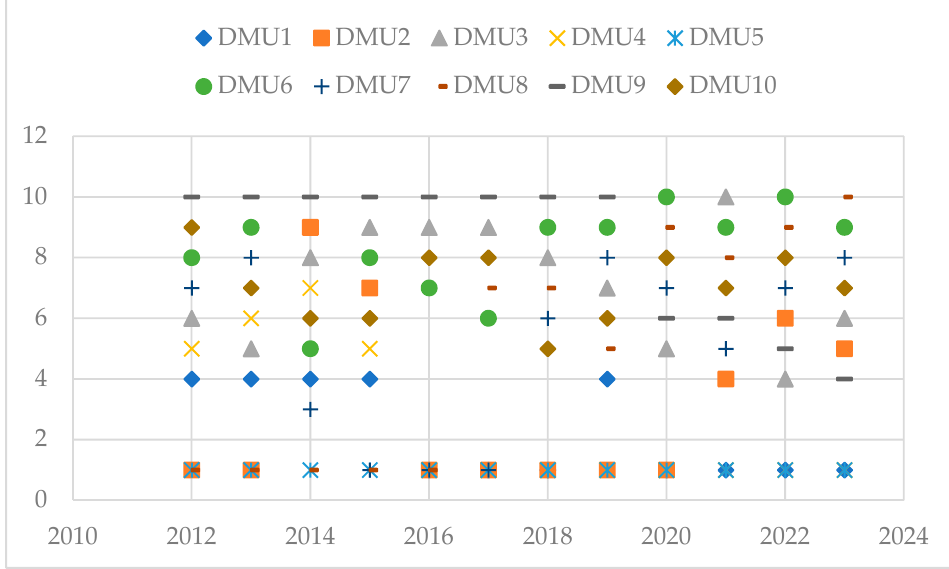
Figure 3. Ranking positions of the DMUs.